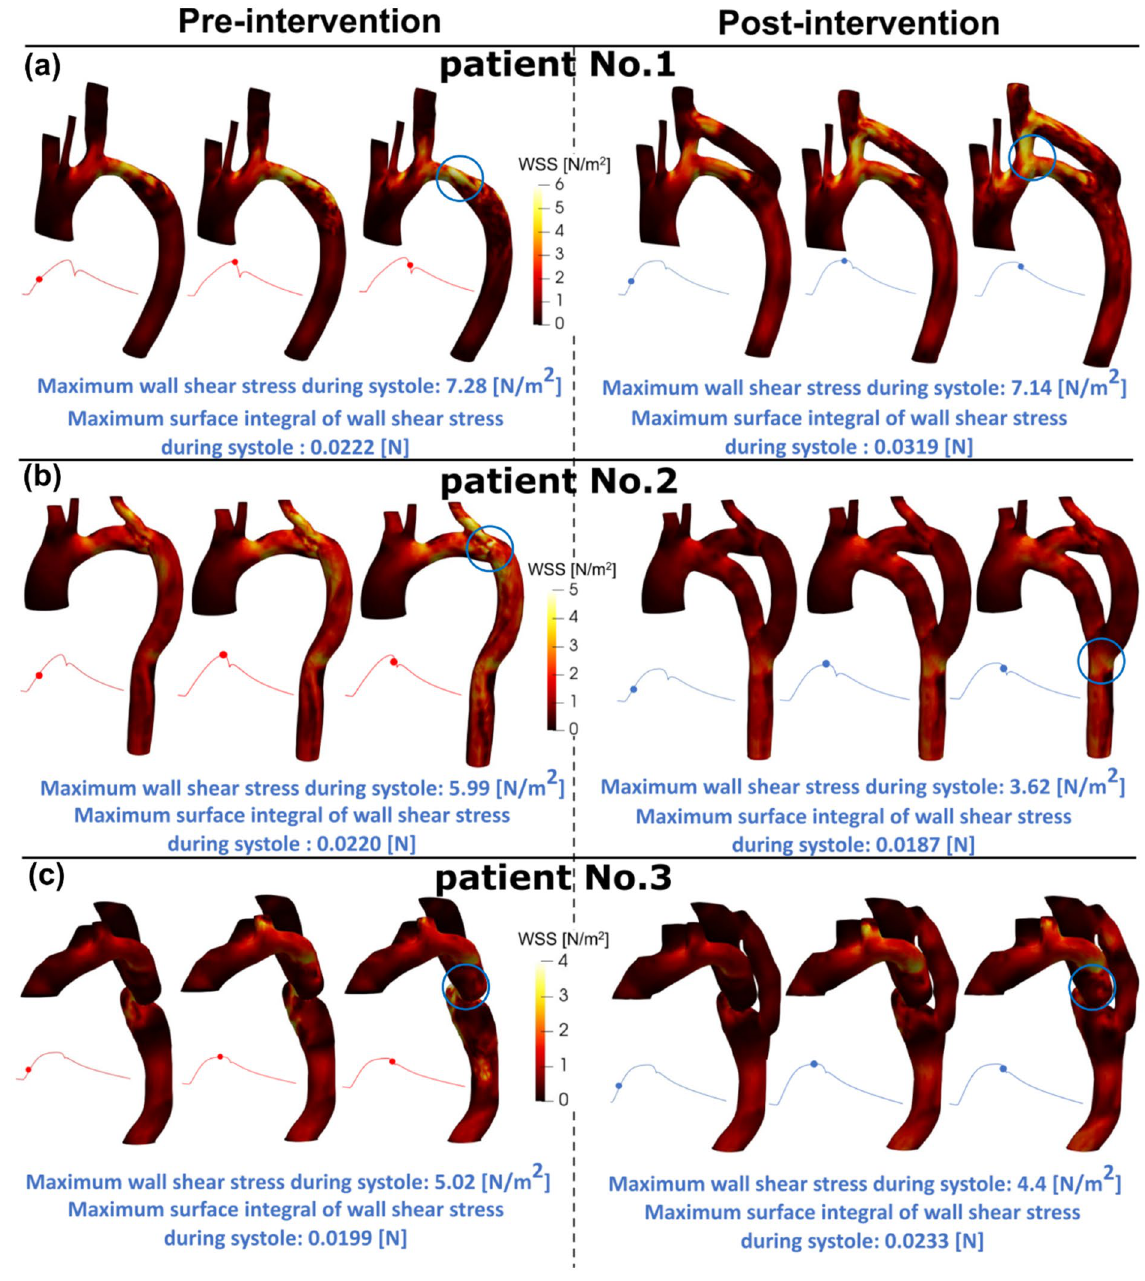
Figure 9. Flow modeling in Patients No. 1, 2 and 3 in pre and post intervention status. ( a ) Wall shear stress in patient #1; ( b ) Wall shear stress in patient #2; ( c ) Wall shear stress in patient #3. Blue circles indicate maximum wall shear stress